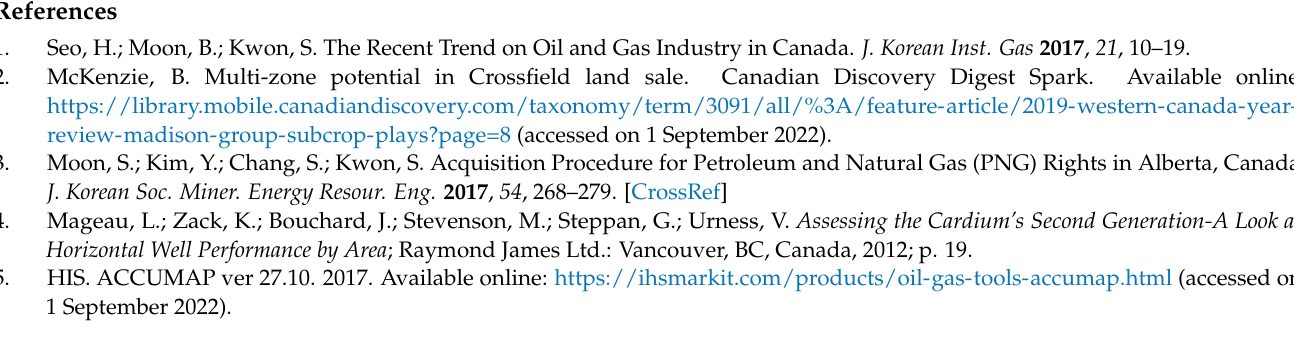
Figure A1. Alberta Royalty Framework Formula for Conventional Oil.